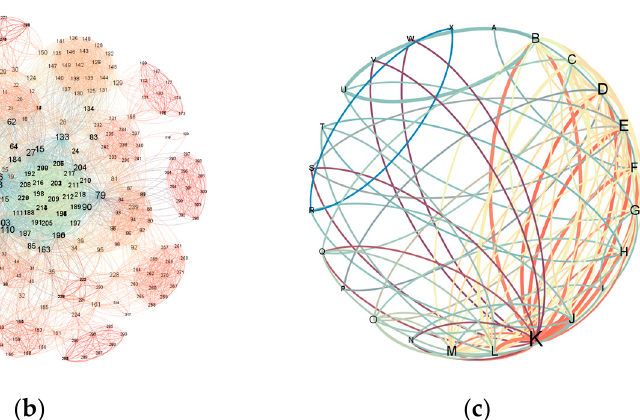
Figure 3. Topological network visualization diagrams. ( a ) Space L network. ( b ) Space P network. ( c ) Space C network.